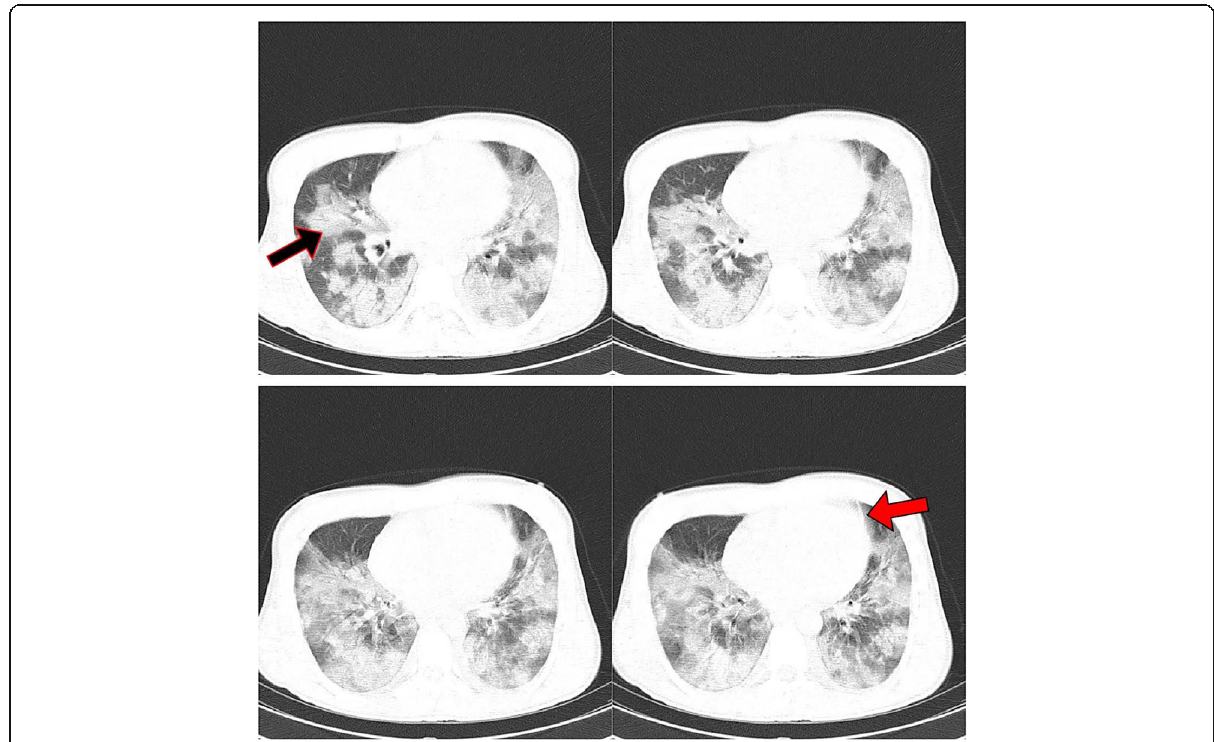
Fig. 2 A 34-year-old male patient presented with fever, chills, myalgia, and dyspnea, who was admitted to ICU for 6 days and was discharged on day 21 of admission. Peripheral and peribronchovascular multilobar ground glass opacities (black arrow), and parenchymal bands (red arrow) are observed in the CT scan. The total CT severity score was calculated as 23, and the disease severity was